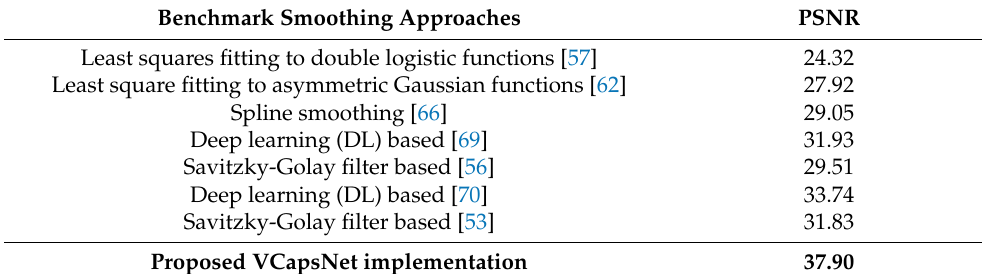
Table 7. Comparison of VCapsNet with benchmark smoothing approaches for 50% of training samples *.